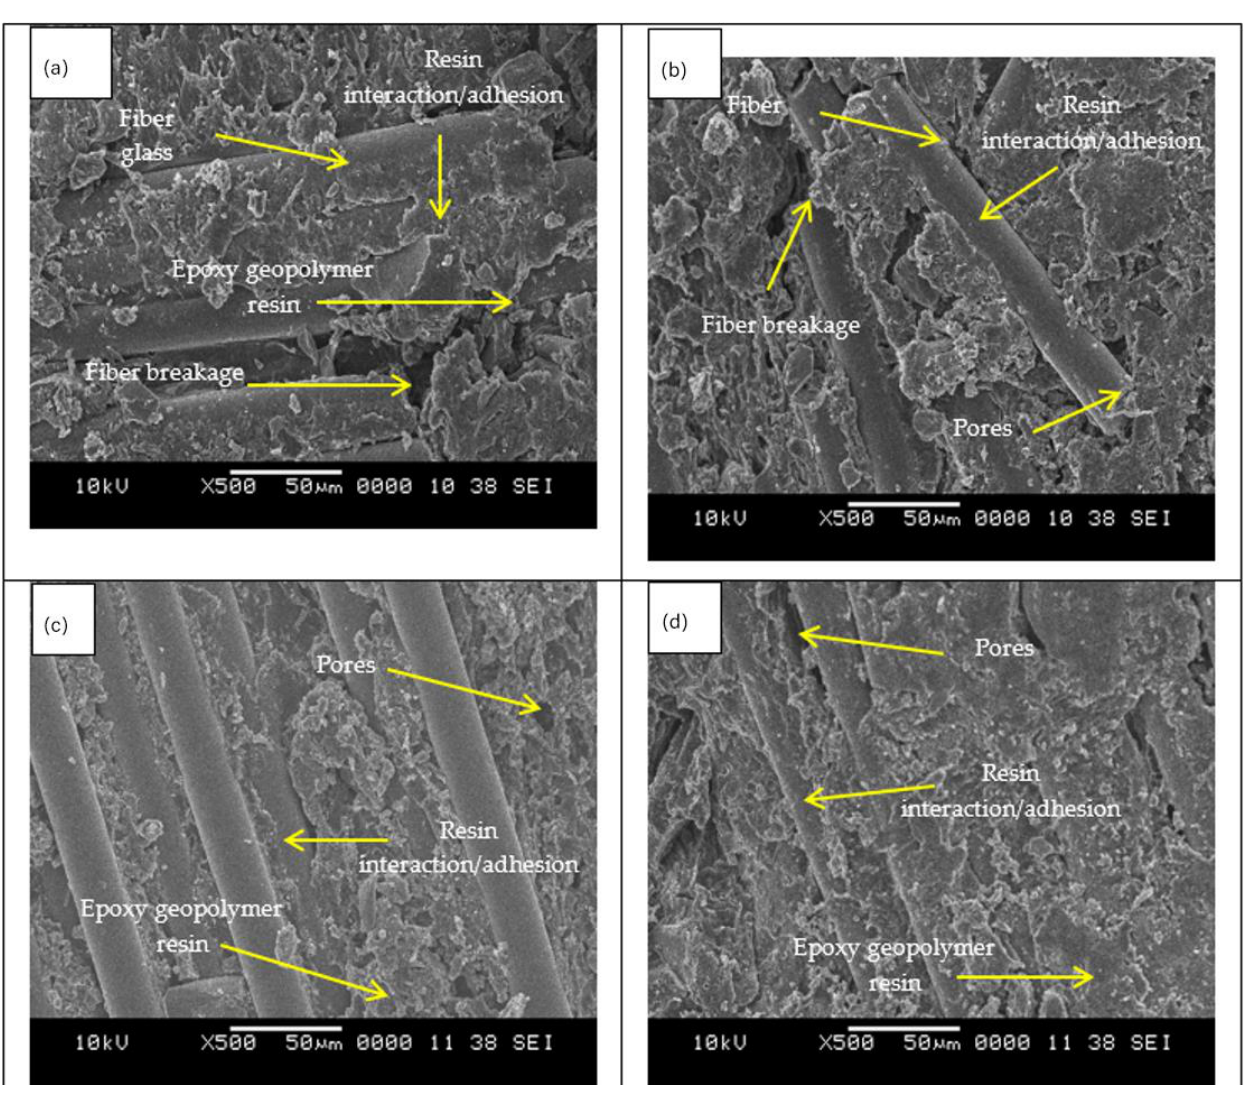
Figure 11. SEM images of GRE-filled high calcium pozzolanic-based geopolymer filler pipe ( a – d ) with different wt% of filler loading. ( a ) 10 wt%, ( b ) 20 wt%, ( c ) 30 wt%, ( d ) 40 wt%.